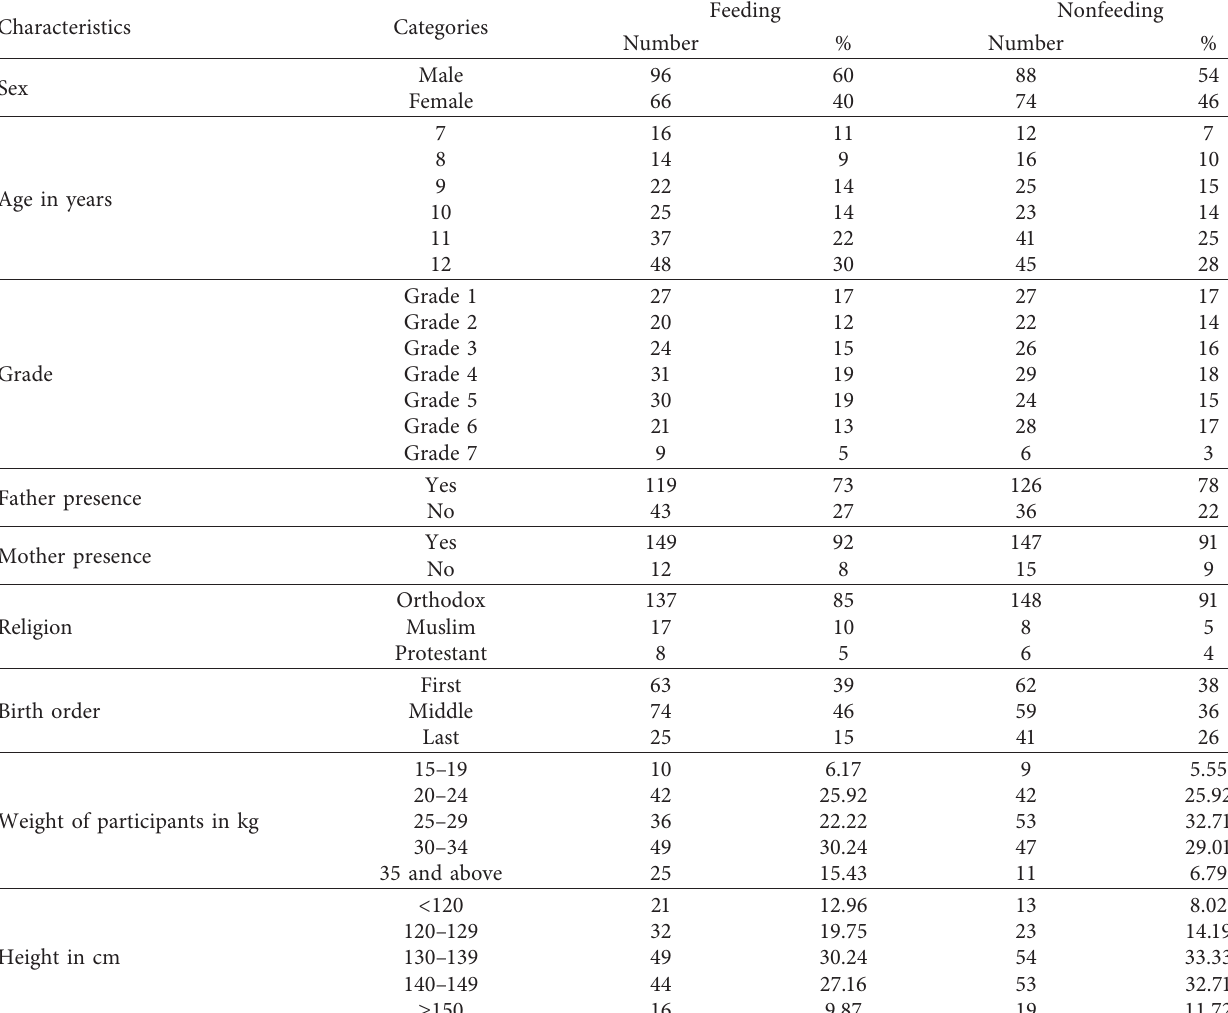
Table 1: Sociodemographic characteristics of participants at selected primary schools in Yeka subcity, Addis Ababa, Ethiopia, August 2018 ( n � 162 for each).